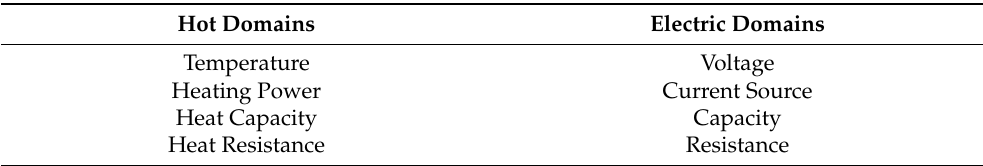
Table 3. Relationship between battery thermal characteristics and electrical characteristic grid